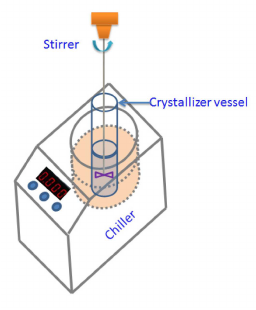
Figure 9. Lab-scale setup for FC